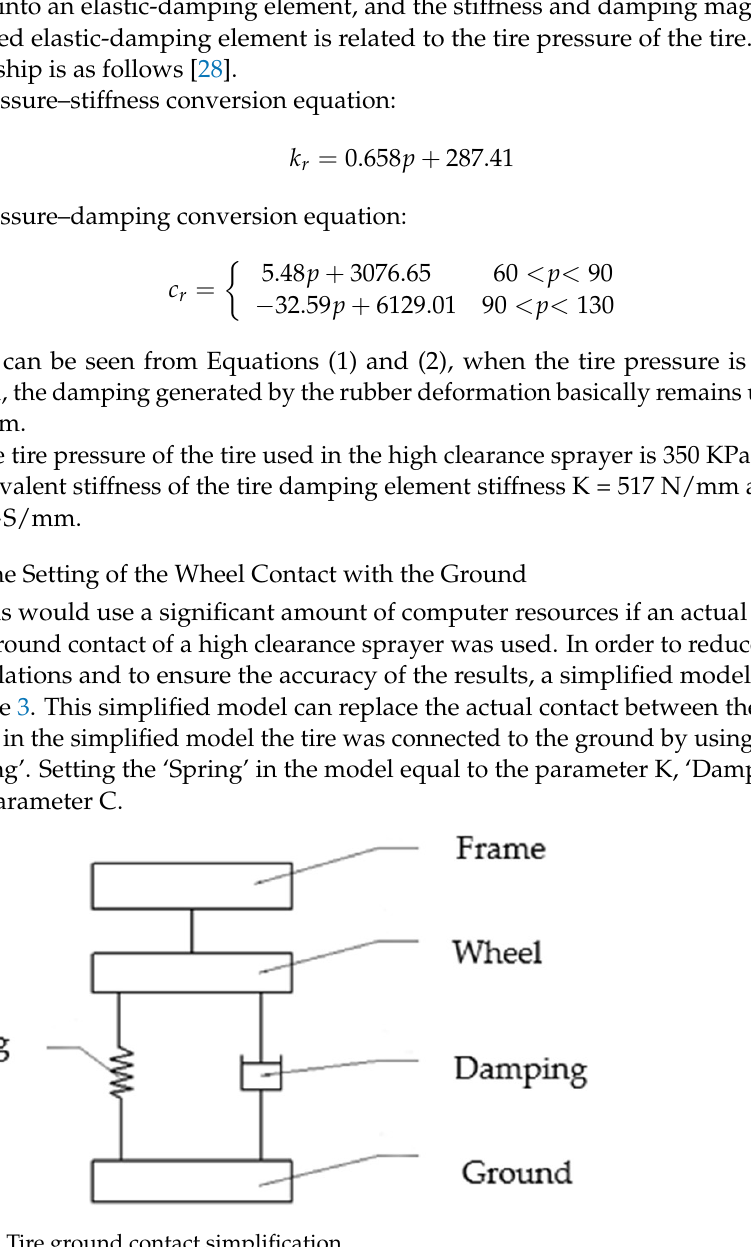
Figure 4. Transient dynamics model for sprayers. The four discs in Figure 4 simplify the ground and are used to load the excitation generated from ground obstacles connected to the hub by stiffness–damping elements. 2.4.3. Determination of the Basic Load The environment is earth road when the sprayer works, and the obstacles are mainly gravel and bricks, so the wheels on one side of the sprayer are set to cross the obstacles with a rectangular cross-section of 50 mm × 30 mm. The displacement change time per- pendicular to the ground directly in the process of the sprayer crossing the obstacle is extremely short; the displacement of the sprayer frame perpendicular to the ground di- rection can be regarded as a linear change to simplify the loading process of the load. The specific load carrying process is shown in Figure 5.